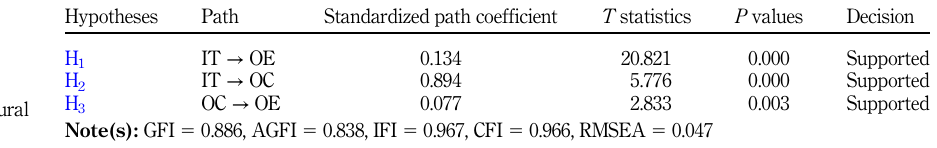
Figure 3. Path diagram